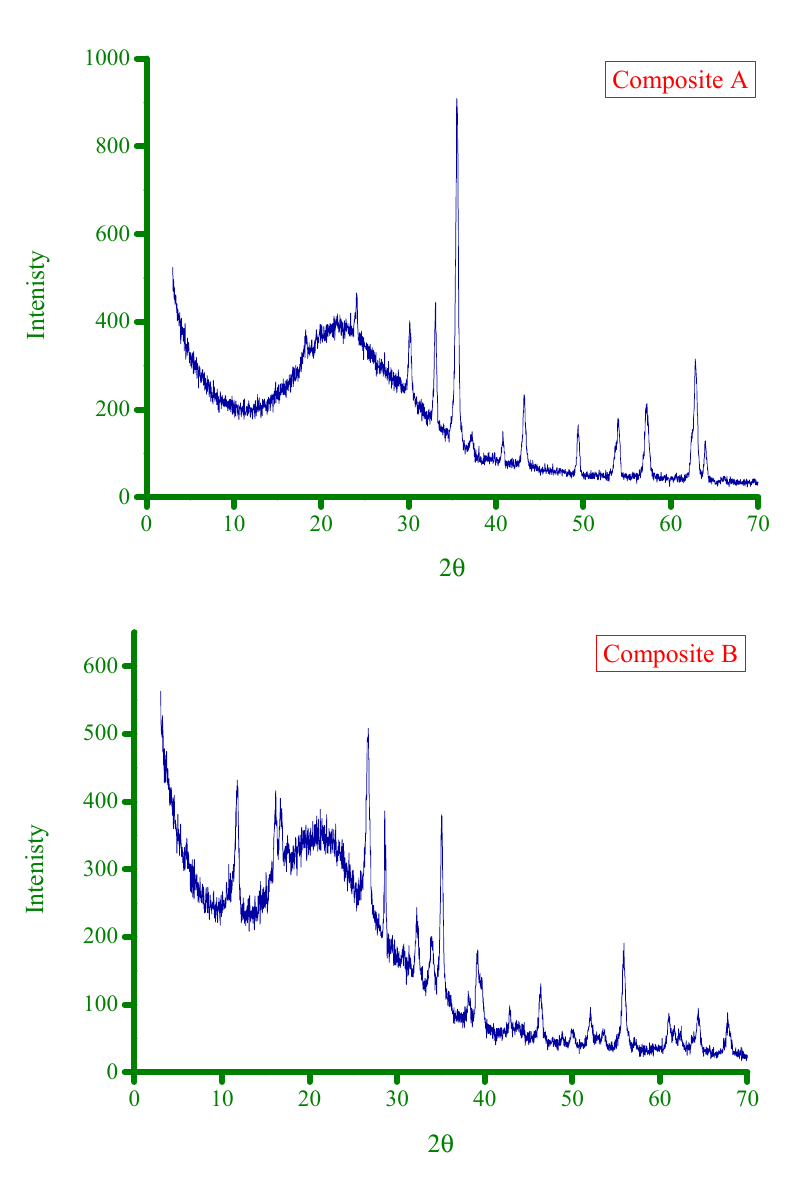
Figure 6. XRD spectra of Composites A and B .